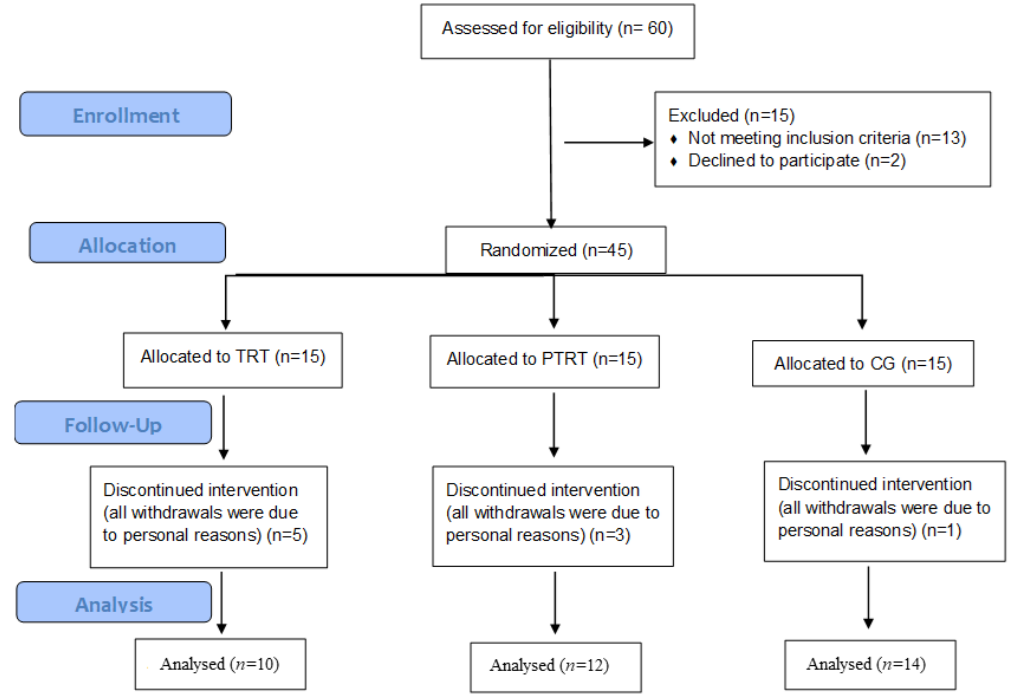
Figure 1. Flowchart of the study. TRT = Traditional resistance training; PTRT = Power training resistance training; CG = Control group.